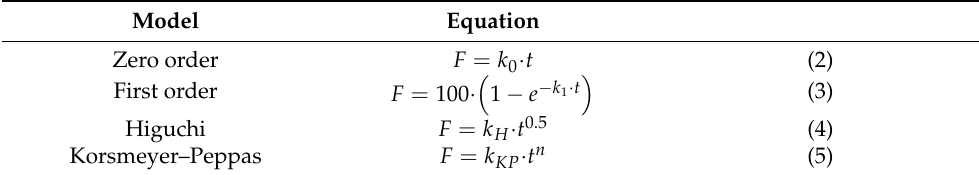
Table 2. Mathematical models to determine the drug release mechanism and kinetics according to Zhang et al. [35]. In the equations, F is the fraction of API released during the time t . The k 0 , k 1 , k H and k KP values are constants for the apparent velocity of dissolution for the corresponding model, n is the diffusional exponent indicating the drug release mechanism.